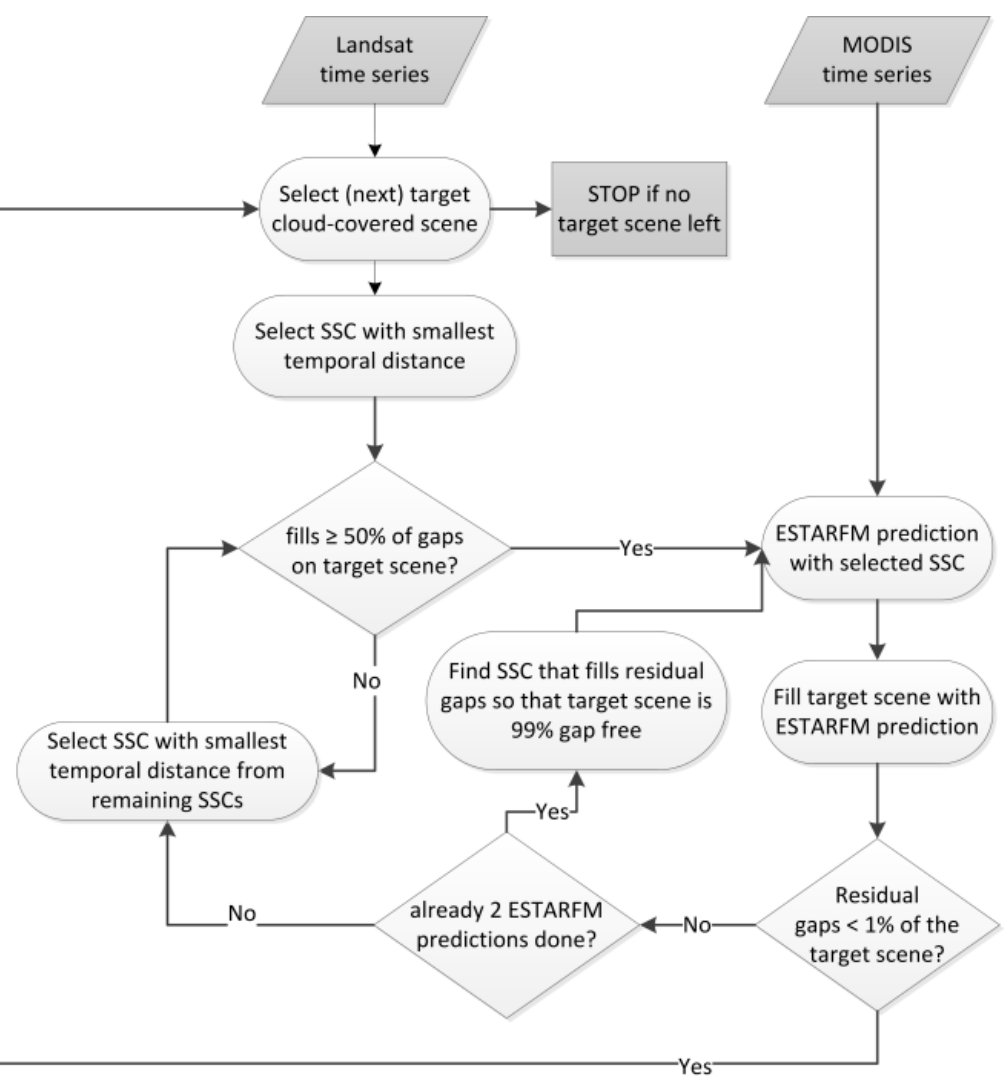
Figure 4. Workflow of the automatic filling of cloud-affected Landsat scenes. The filling is based on ESTARFM predictions for the gaps in the target scene. Shoulder scene combinations (SSC) are automatically selected after a certain ruleset and then used as input for ESTARFM. A maximum of three synthetic scenes are generated this way to fill one target scene.